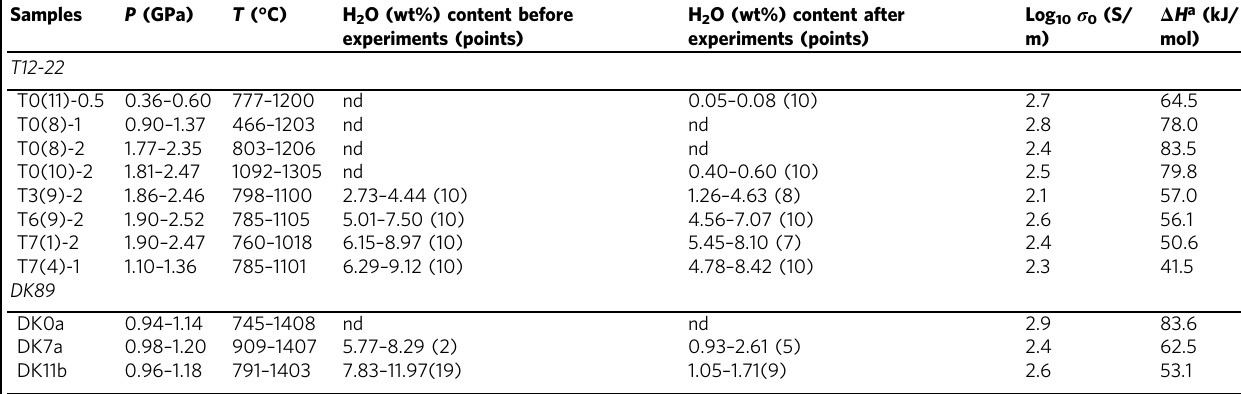
Table 2 Experimental details and results of the melt conductivity measurements